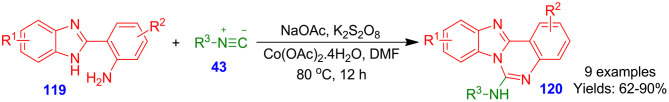
Co-catalyzed isocyanide insertion-cyclization for constructing benzoimidazoquinazoline frameworks.